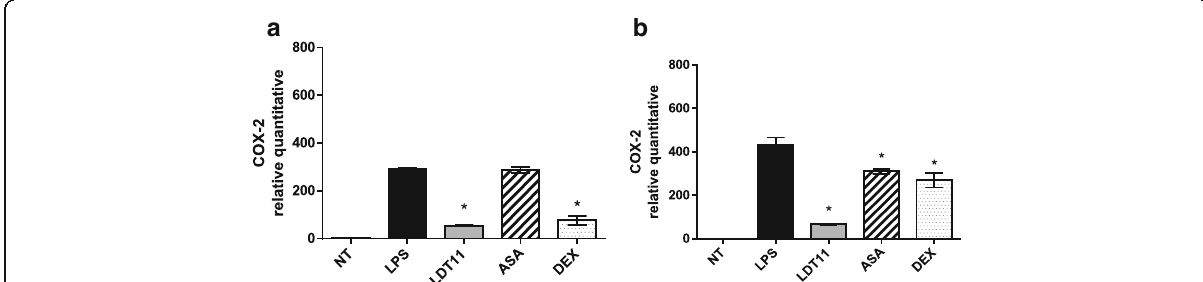
Fig. 6 Determination of the relative amount of COX-2 gene transcripts in RAW 264.7 cell line for the evaluation of inflammatory response at 6 ( a ) and 24 h ( b ) post-stimulus. NT- untreated cells; LPS - LPS-stimulated cells; LDT11 - cells treated with LDT11 and then with LPS; AAS - cells treated with commercial acetylsalicylic acid and then with LPS; DEX - cells treated with the commercial anti-inflammatory Dexamethasone and then with LPS. All data are from at least three independent experiments, * p < 0.05, statistically different compared with cells